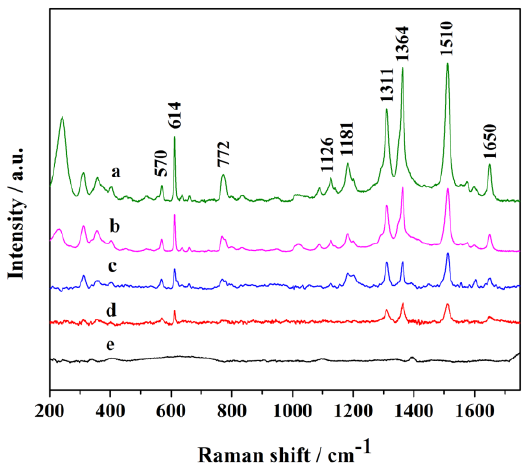
Figure 7. Raman spectra of Rhodamine 6G (R6G) at different concentrations absorbed on Ag nanorod aggregates. Spectra represent the concentrations of R6G being ( a ) 5 × 10 −6 ; ( b ) 5 × 10 −7 ; ( c ) 5 × 10 −8 ; ( d ) 5 × 10 −9 ; ( e ) 5 × 10 −10 M, respectively.